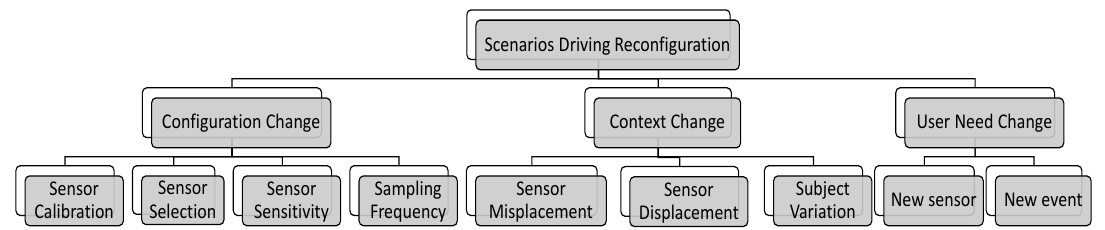
Figure 1. Classification of heterogeneity (variations) in M-health monitoring